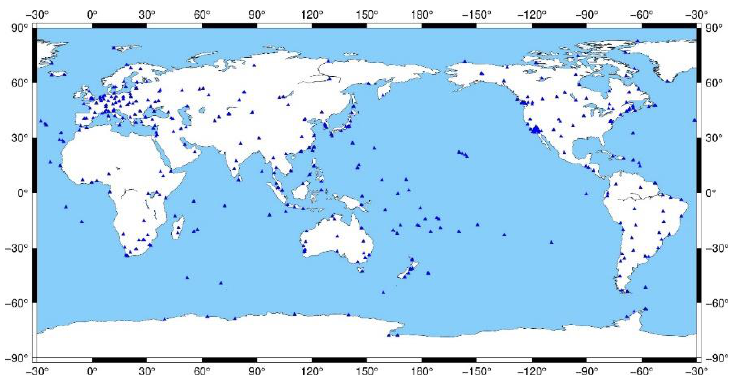
Figure 3. Distribution of MGEX sites.